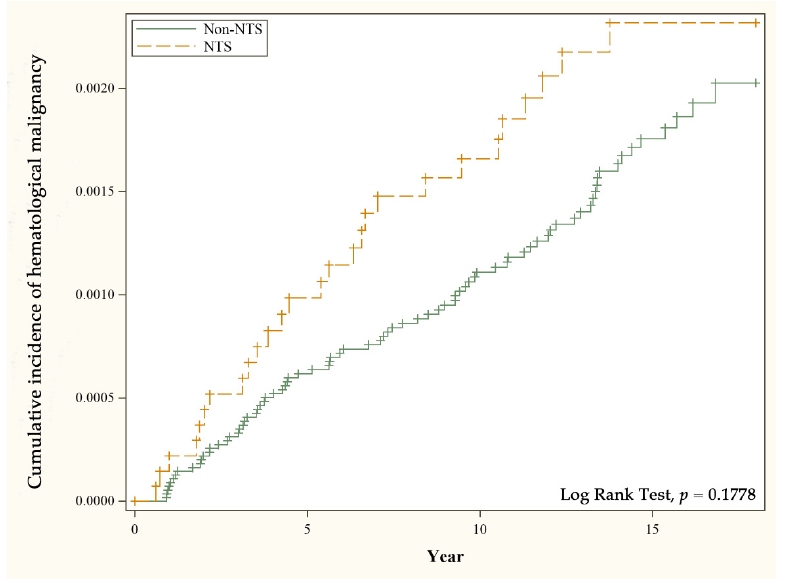
Figure 1. Cumulative incidence of hematological malignancy for patients with and without nonty- phoidal salmonellosis. A comparison of the incidence of hematological malignancy between NTS and non-